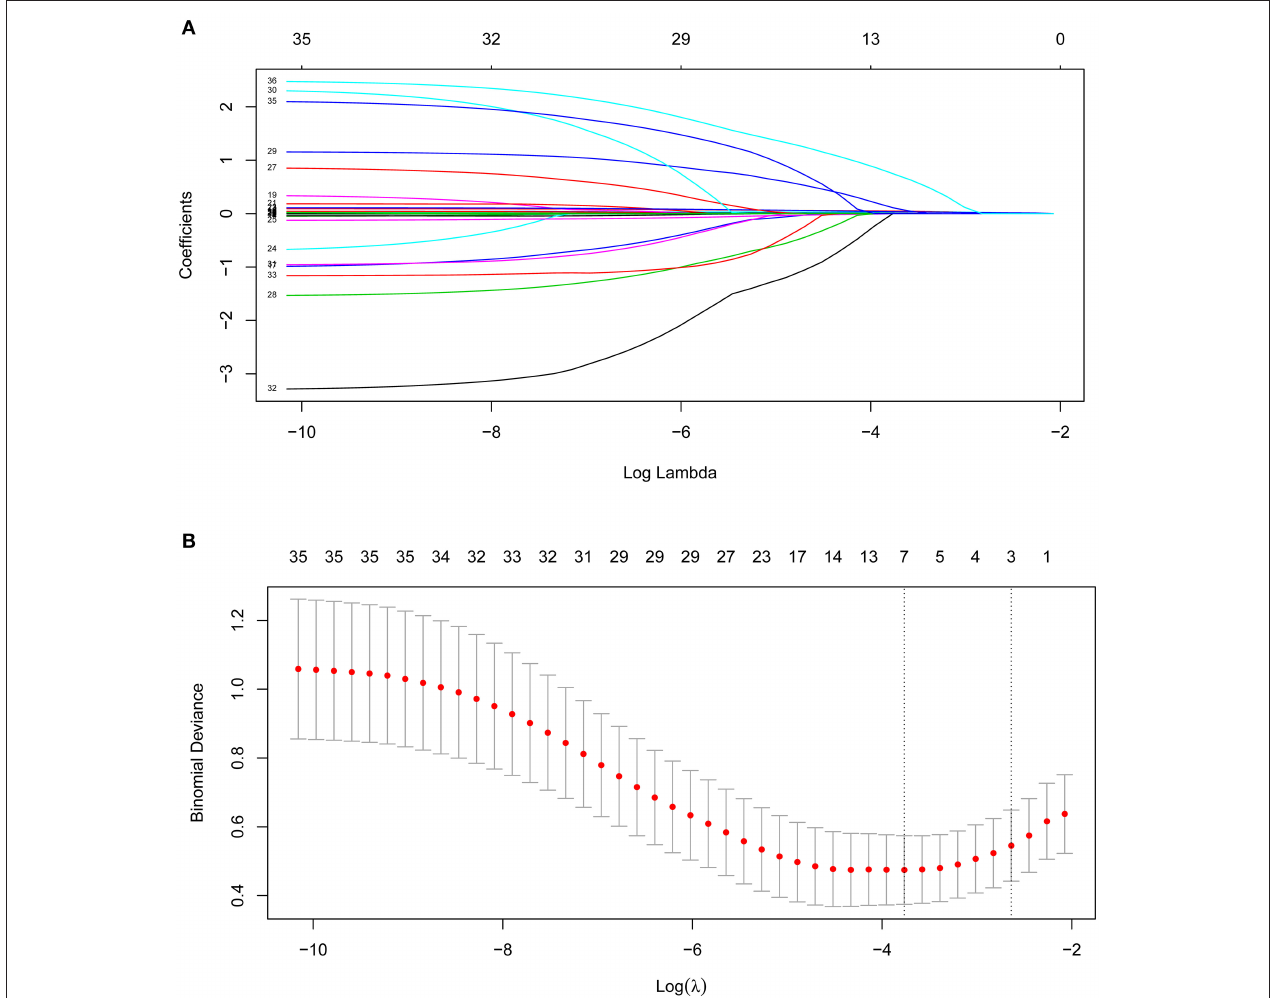
FIGURE 2 | Clinical variables were selected using the lasso logistic regression model. (A) Tuning parameter ( λ ) selection using LASSO penalized logistic regression with 10-fold cross-validation. (B) LASSO coefficient profiles of the radiomic